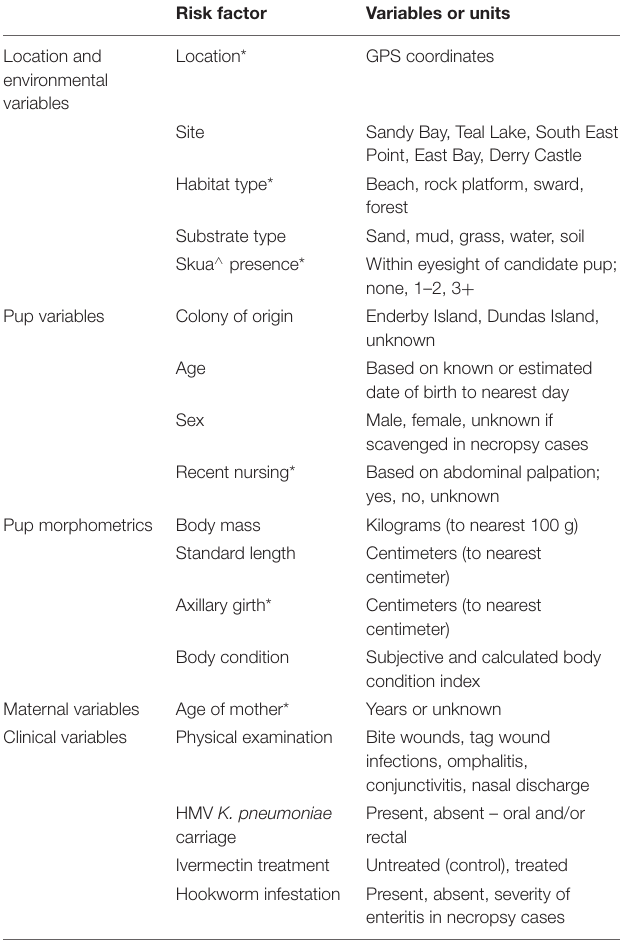
TABLE 1 | Summary of risk factor data collected during and following NZ sea lion ( Phocarctos hookeri ) pup captures at Sandy Bay, Enderby